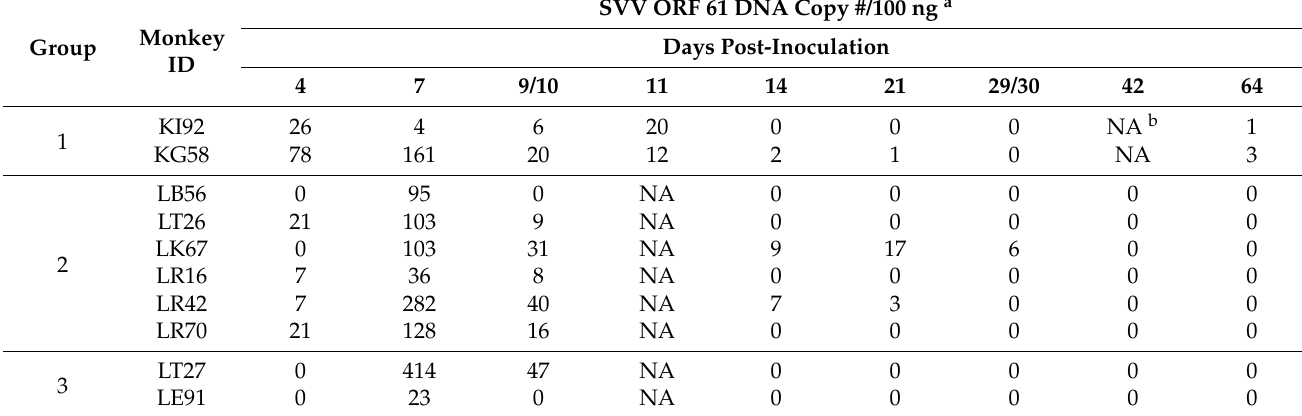
Table 3. Viremia during varicella.